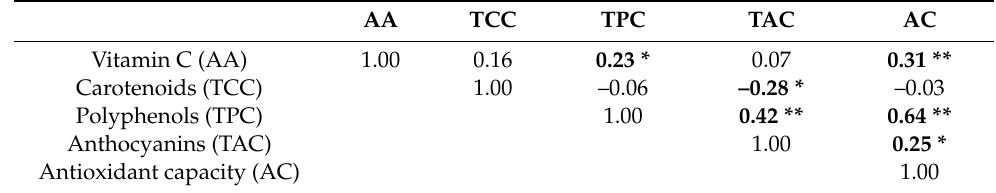
Table 3. Pearson correlation coe ffi cient (r) between the analytical parameters: content of vitamin